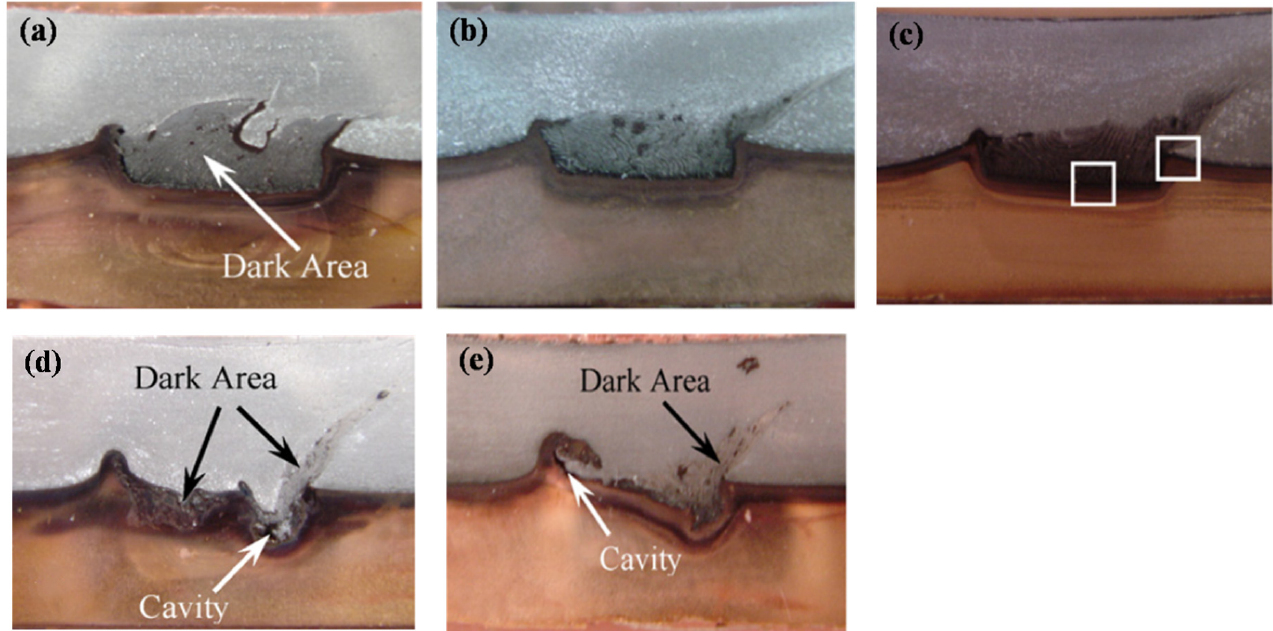
Figure 12. Macroscopic overviews of the FSW joint cross sections at the constant tool rotational speed of 1180 rpm and welding speeds of ( a ) 30, ( b ) 60, ( c ) 95, ( d ) 118 and ( e ) 190 mm/min (adapted from [6], with permission from Elsevier, 2010).